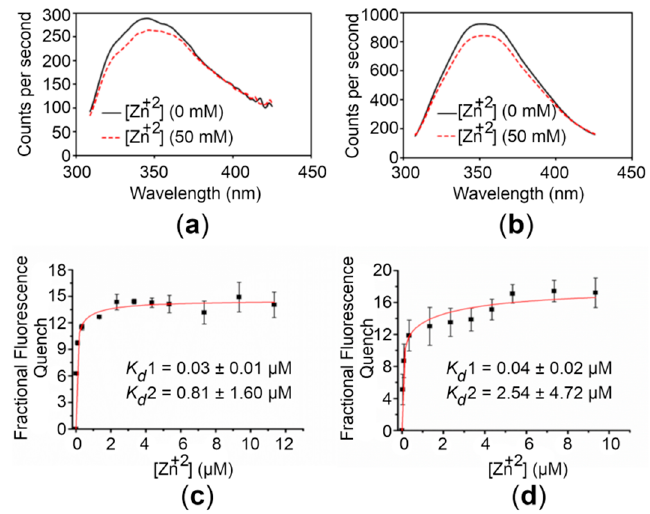
Figure 3. Zn +2 binding analysis of the hZnT8 CTDs. ( a,b ) Fluorescence emission spectra of the WT CTD ( a ) and the R325W CTD ( b ) before (continuous lines) and after (dotted lines) addition of 50 mM Zn +2 are shown. ( c,d ) Concentration-dependent Zn +2 -binding affinity curves for the WT CTD ( c ) and the R325W CTD ( d ). The apparent affinities ( K d values) for Zn +2 binding to the WT CTD and the R325W CTD were obtained by nonlinear fitting of the respective quench/concentration curves to a two-binding-site model. The excitation and emission wavelengths used in the experiments were 285 nm and 350 nm, respectively. Fluorescence was recorded at excitation and emission slit widths of 2.0. Data points and error bars represent the mean and standard deviation of three individual measurements, respectively.